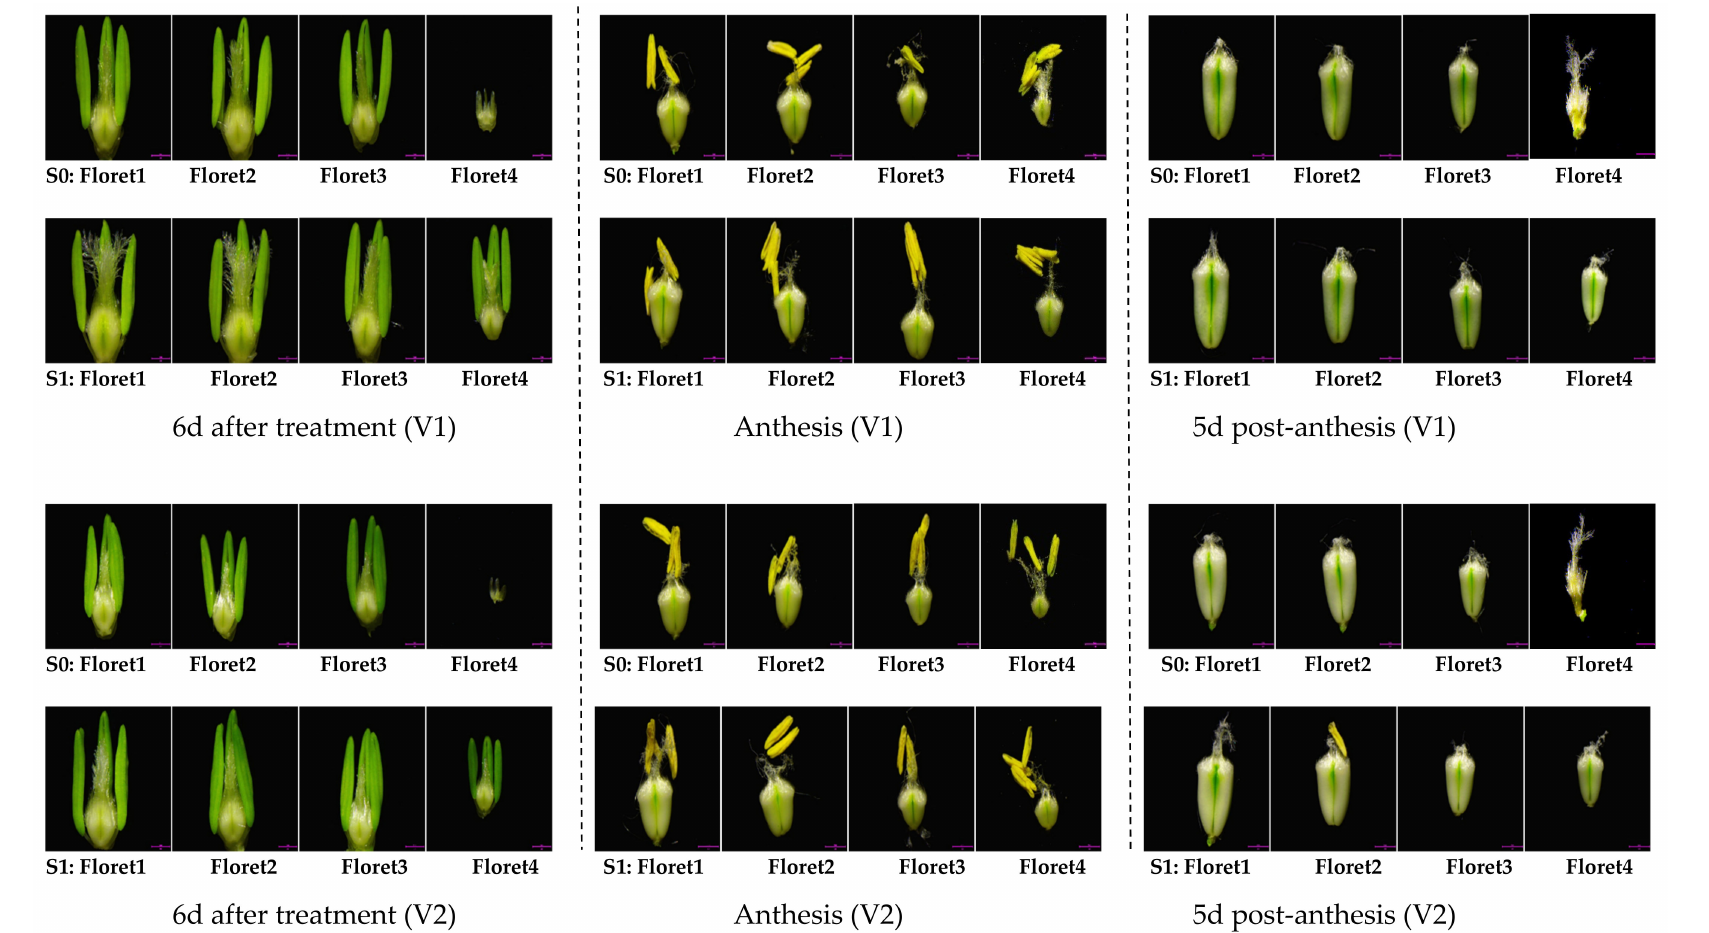
Figure 6. Di ff erences in the development characteristics and likelihood of grain set in di ff erent floret positions under exogenous 6-BA treatment and the control. Images using floret 1, floret 2, floret 3, and floret 4 of spikelet 9 (Figure S1) that attributed the middle part of the